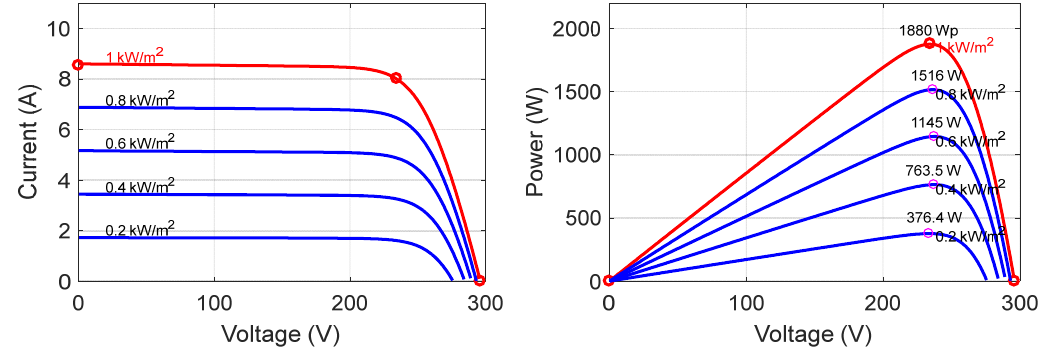
Figure 5. I-V and P-V characteristic of studied PV generator.